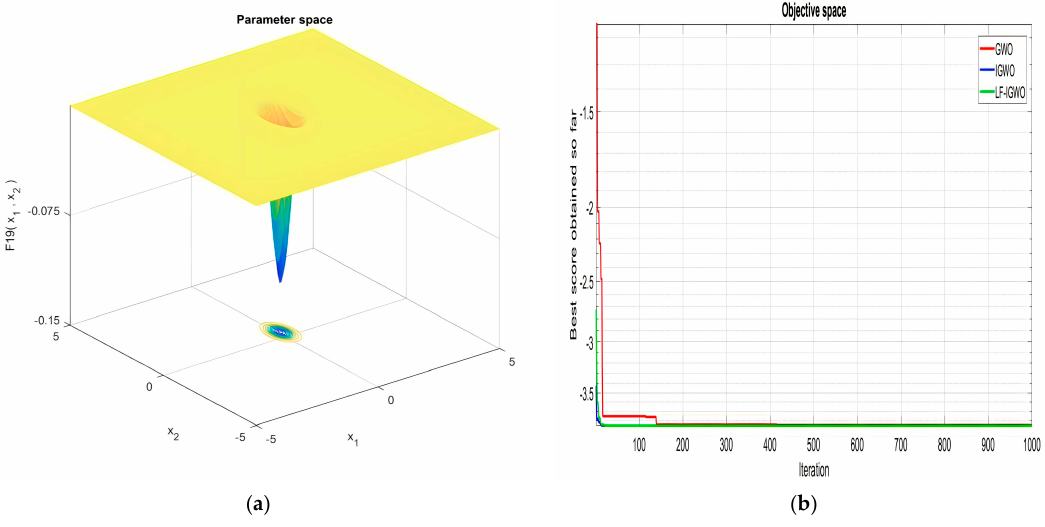
Figure 20. ( a ) Search space for fi xed dimensional function F18 ( b ) Comparison of convergence curve for F18.